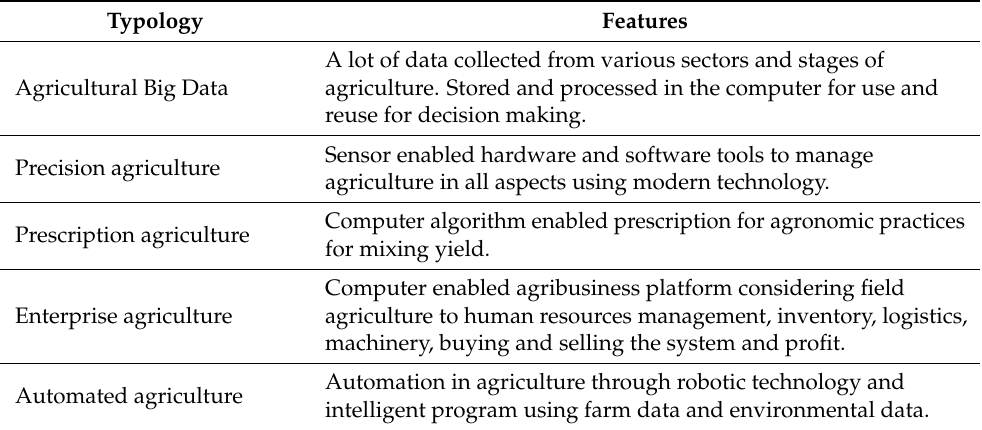
Table 2. Typologies in digital agriculture